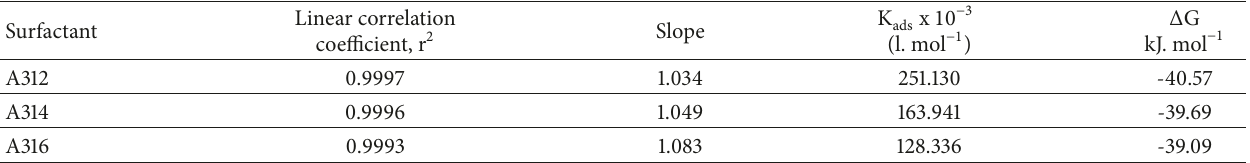
Figure 4: Nyquist plots for API X52 steel in 1 M HCl with different concentrations of the synthesized corrosion inhibitors, (a) A312, (b) A314, and (c) A316. Table 5: Adsorption parameters of synthesized inhibitors on the steel